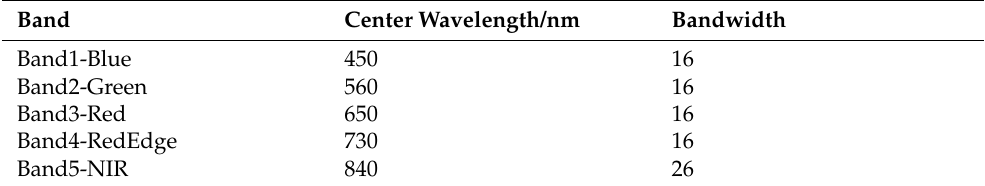
Table 3. The multispectral bands of UAV.